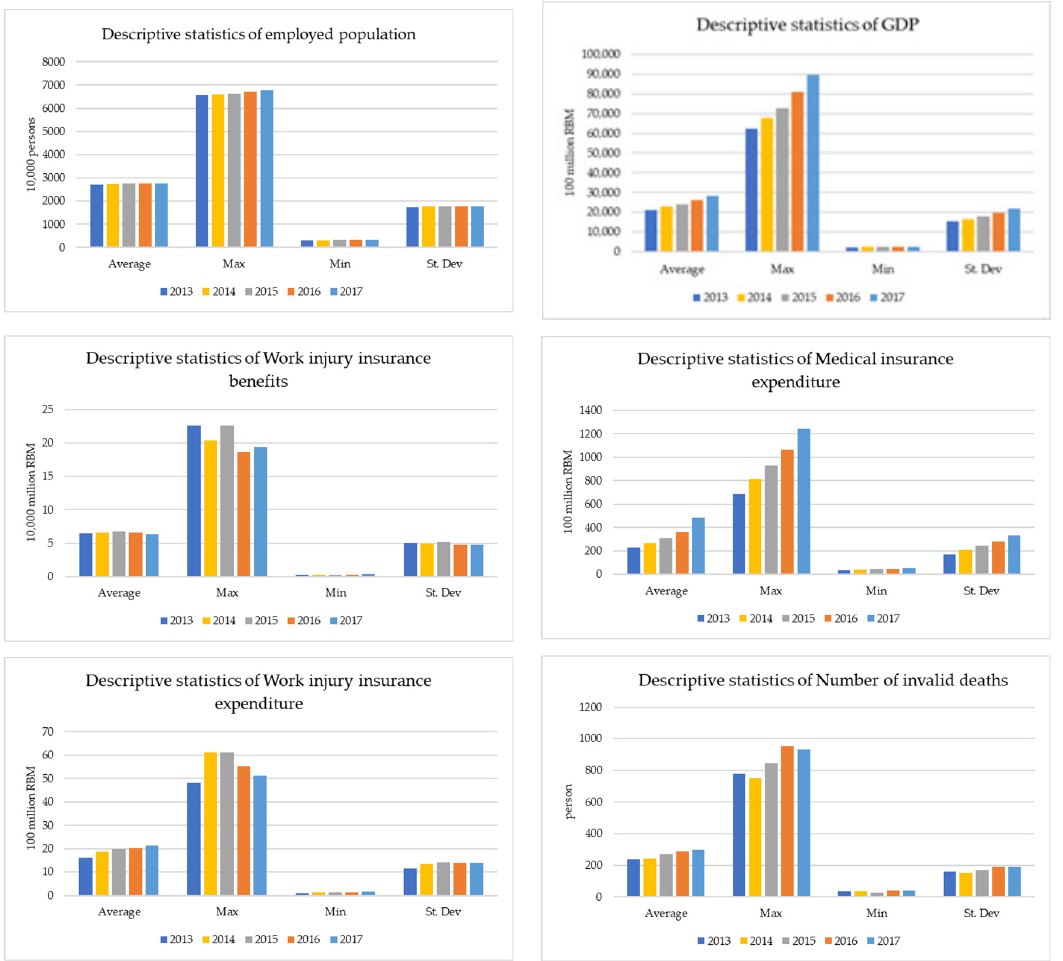
Figure 2. Input–output statistics (2013–2017).